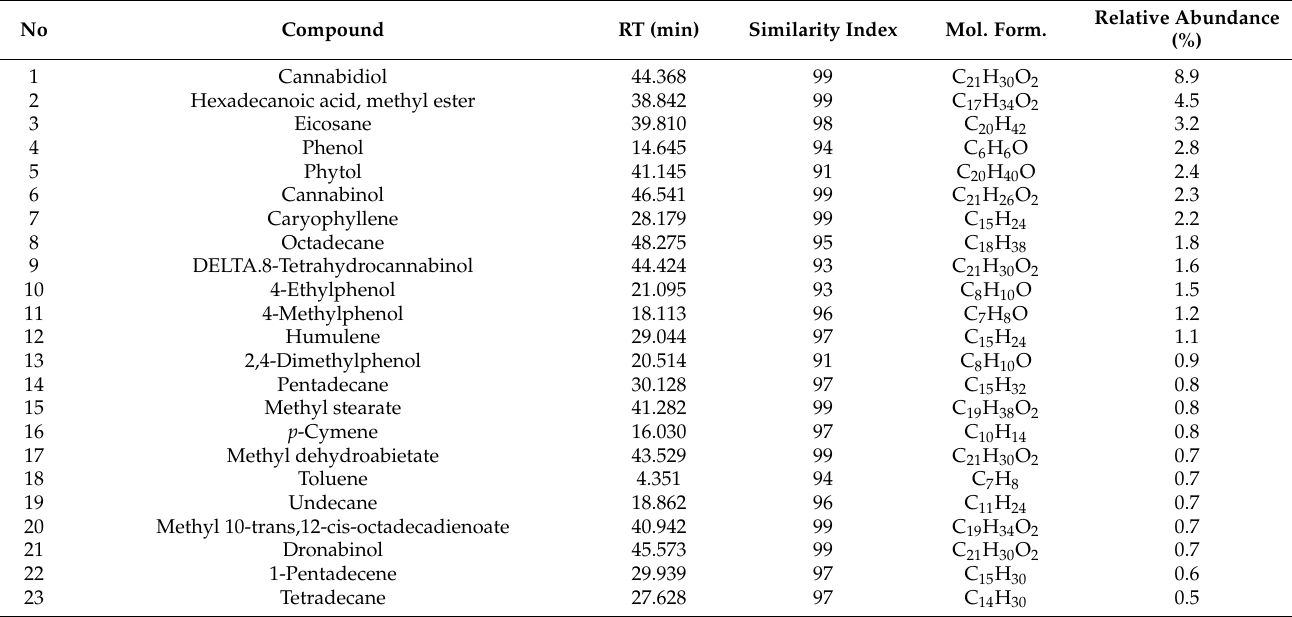
Table 8. Chemical composition of distillates of hemp leaves (LV2B) from pyrolysis stages (PS) condensed at 70 ◦ C analyzed by GC-MS.